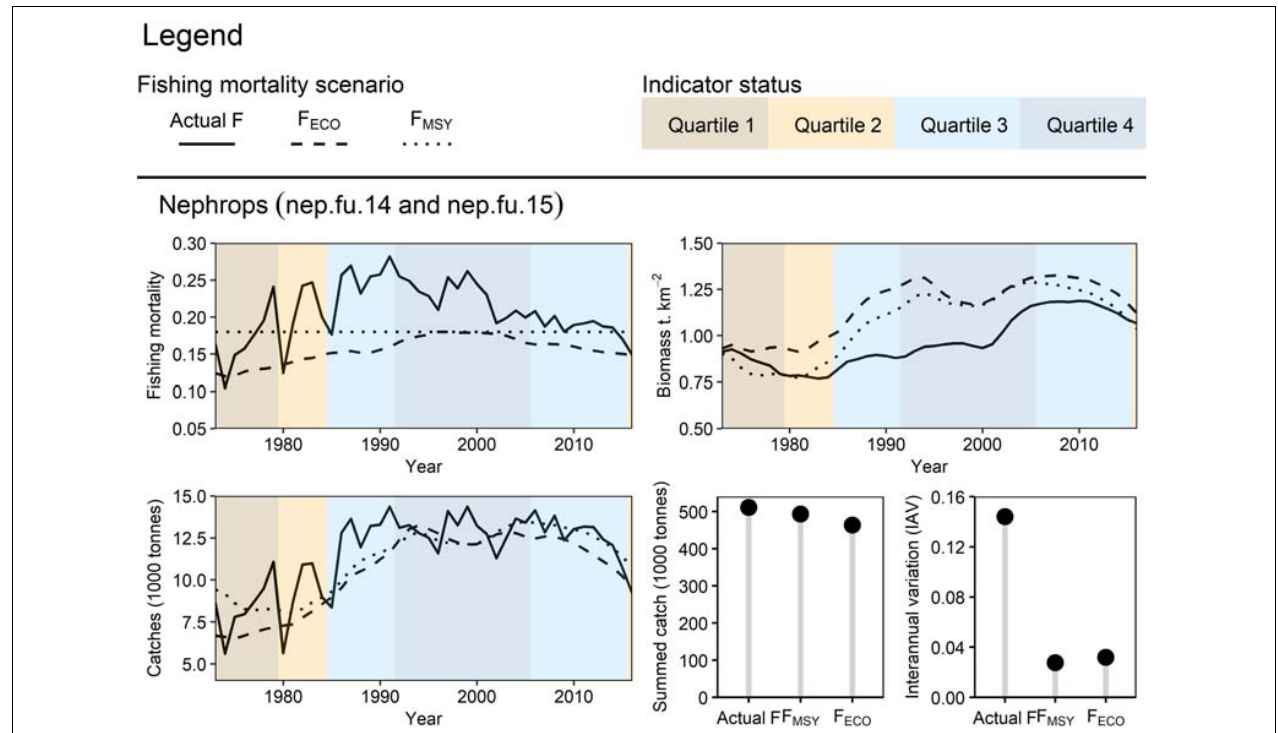
FIGURE 9 | Retrospective application of F ECO for Irish Sea Nephrops : Three fishing mortality scenarios were prepared to simulate Irish Sea Nephrops dynamics from 1976-2016. F ECO was retrospectively calculated based on the condition of the trophic level 4+ biomass indicator. The different fishing mortality trends were applied to Nephrops in the EwE model to simulate their effect on the stock’s biomass and catch (trend, total yield, and interannual